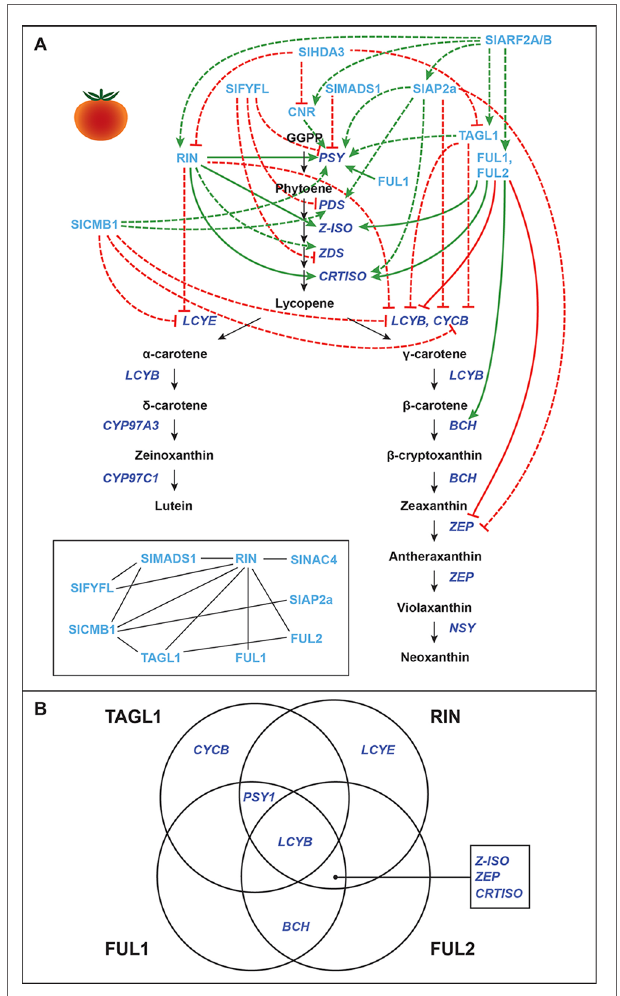
FIGURE 2 | Transcriptional regulation of CBP genes in tomato fruits: “ripening quartet”–related proteins. (A) The regulation of CBP genes in tomato fruits. The carotenoid biosynthesis pathway is in black, with carotenoid biosynthesis genes indicated in dark blue. Carotenoid regulators discussed in the paper are shown in light blue. Green arrows indicate positive regulation, while blunt red arrows indicate negative regulation. Solid lines show direct interactions, while dotted lines show indirect/unknown interactions. Inset: protein–protein interactions between “ripening quartet” regulators. (B) Venn diagram showing the direct binding of TAGL1, RIN, FUL1, and FUL2 to CBP gene